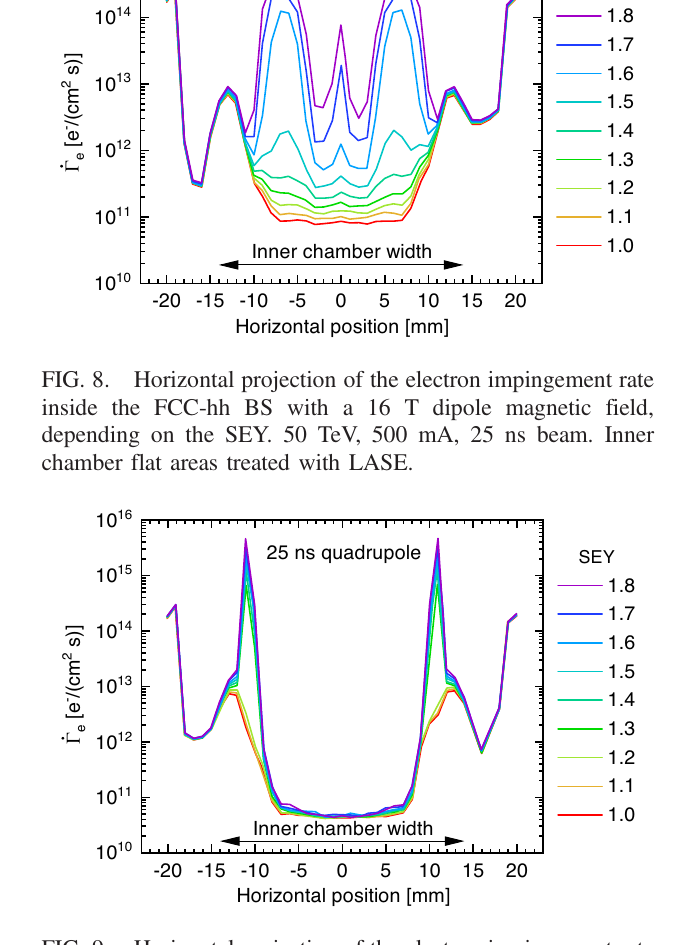
FIG. 9. Horizontal projection of the electron impingement rate inside the FCC-hh BS with a 360 T = m quadrupole magnetic field, depending on the SEY. 50 TeV, 500 mA, 25 ns beam. Inner chamber curved areas with LASE.